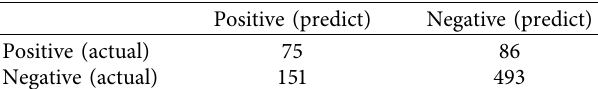
Table 12: Confusion matrix of the updated low precision data set model.